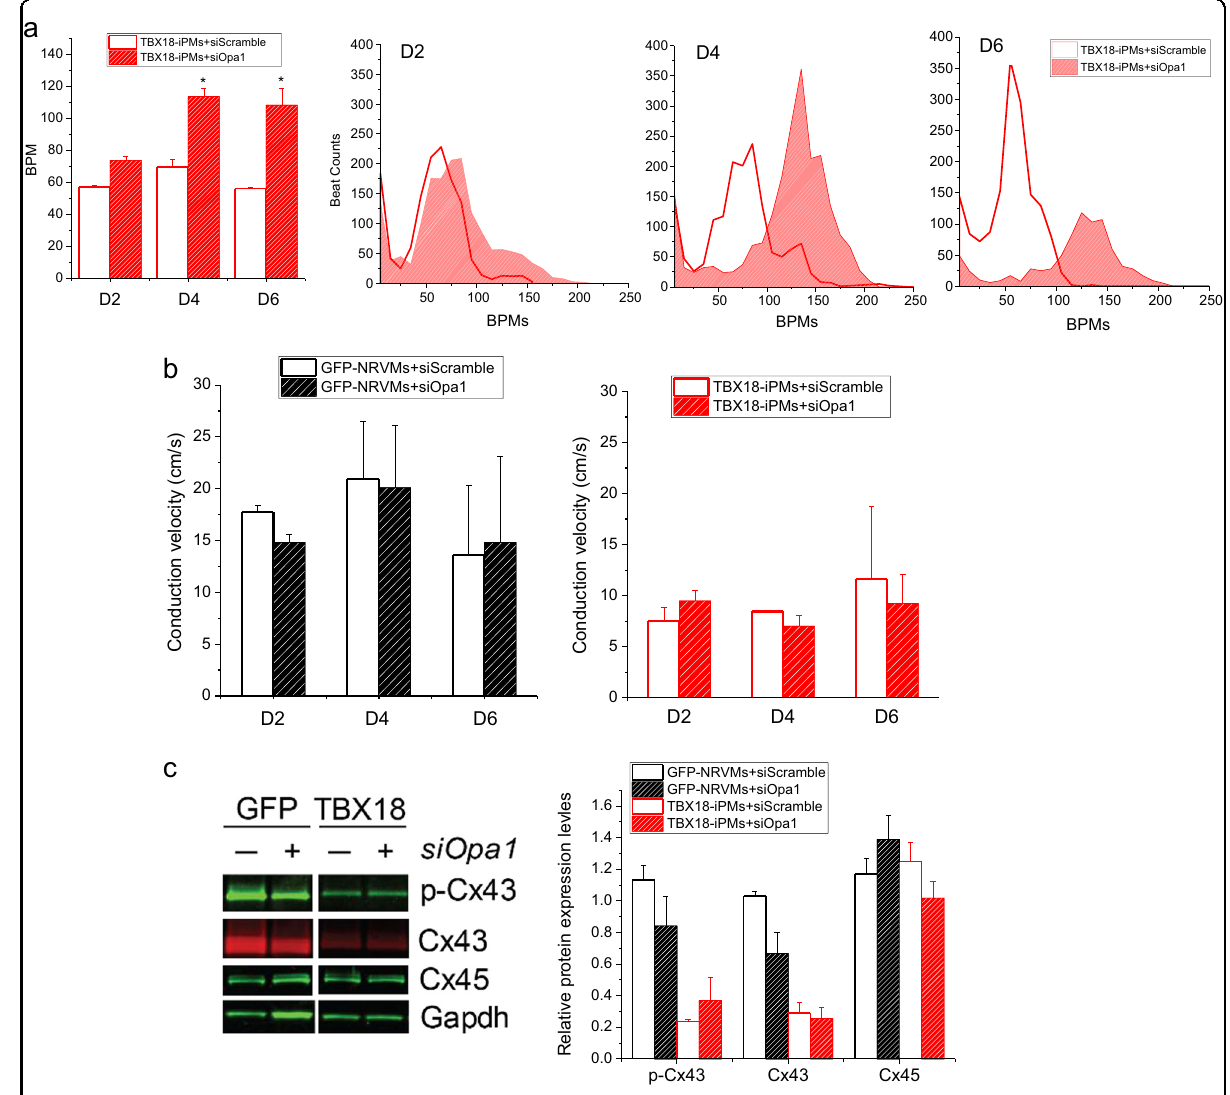
Fig. 5 Mitochondrial dynamics regulate the synchronous automaticity of TBX18-iPMs. a BPMs of synchronous beats from siScramble- or siOpa1-transfected TBX18-iPMs on D2, D4, and D6 after transfection ( n = 5). Representative distribution of synchronous beats from siScramble- or siOpa1-transfected TBX18-iPMs on D2, D4, and D6 after transfection (right three panels). b Conduction velocity of spontaneous synchronous beatings from GFP- and TBX18-NRVMs with or without Opa1 knockdown on D2, D4, and D6 after transfection ( n = 5). c Relative protein levels of selected gap junctions, including phosphorylated Cx43 (p-Cx43), Cx43, and Cx45, were analyzed in D4 GFP-NRVMs and TBX18-iPMs ( n = 4). Representative immunoblots are shown on the left and a quantitative graph is presented on the right. BPM: Beats per minute. Scale bar: 5 μ m * p <